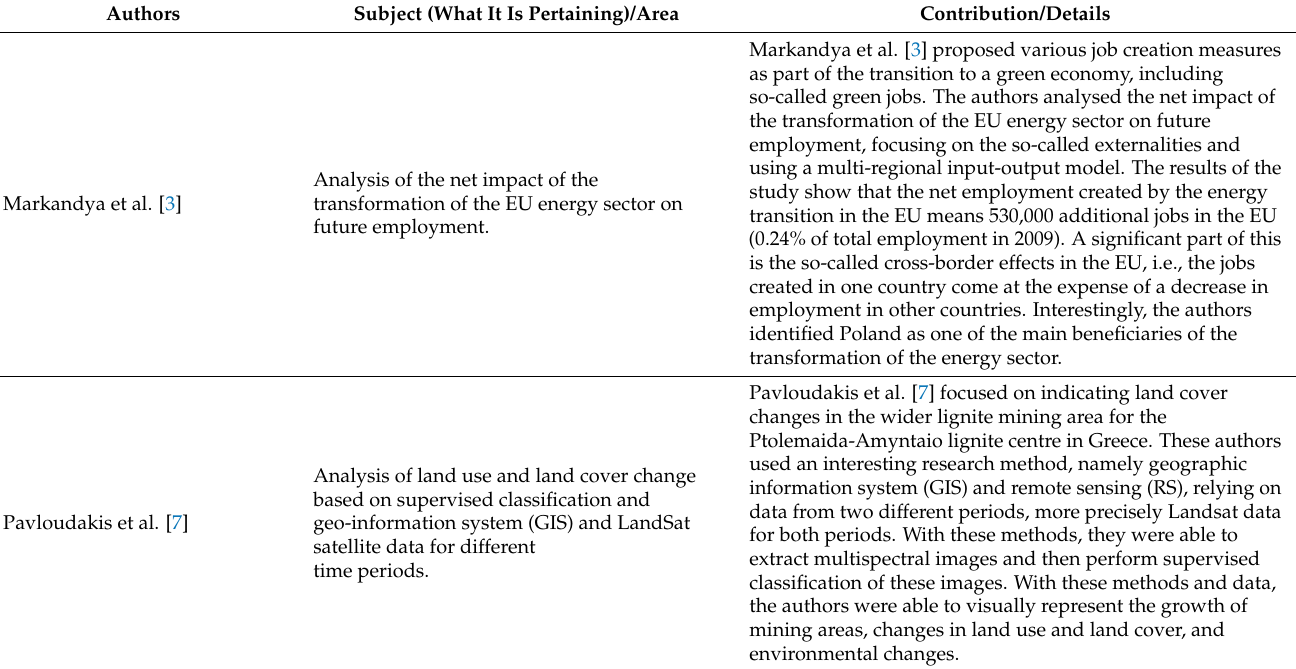
Table A1. Important works/studies dealing with opencast lignite mining and its socio-economic and ecological significance (scientific